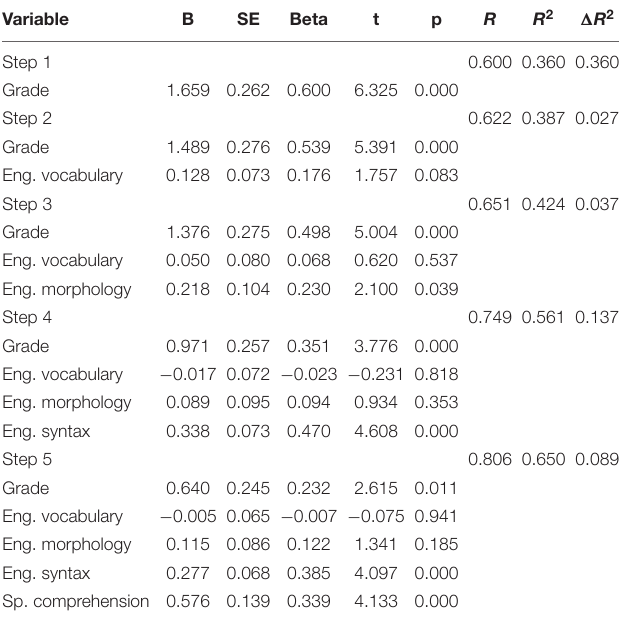
TABLE 5 | Summary of hierarchical regression analysis for variables predicting the outcome English reading